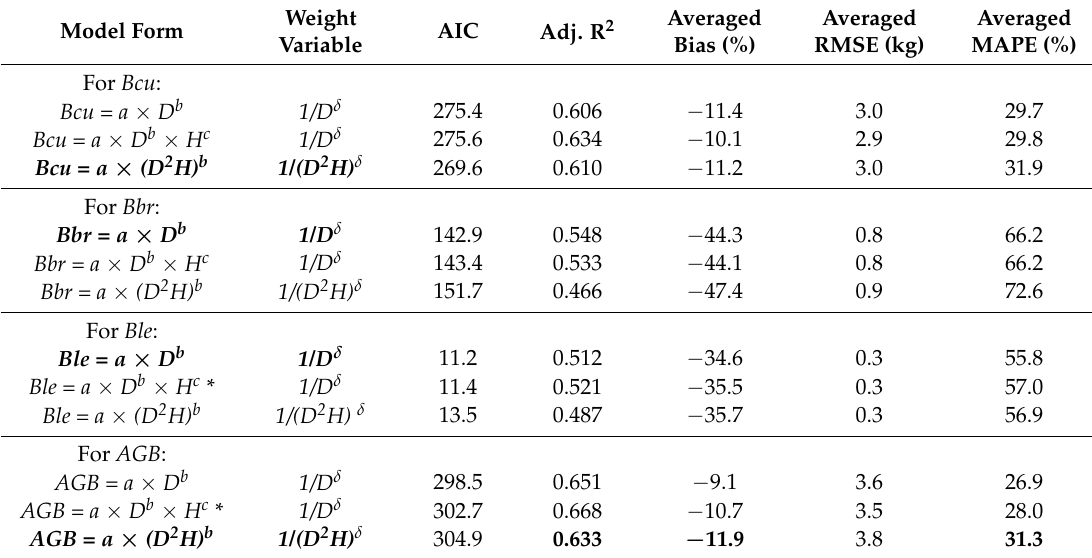
Table 2. Cross-validation and comparison of selected biomass models for each component and bamboo aboveground